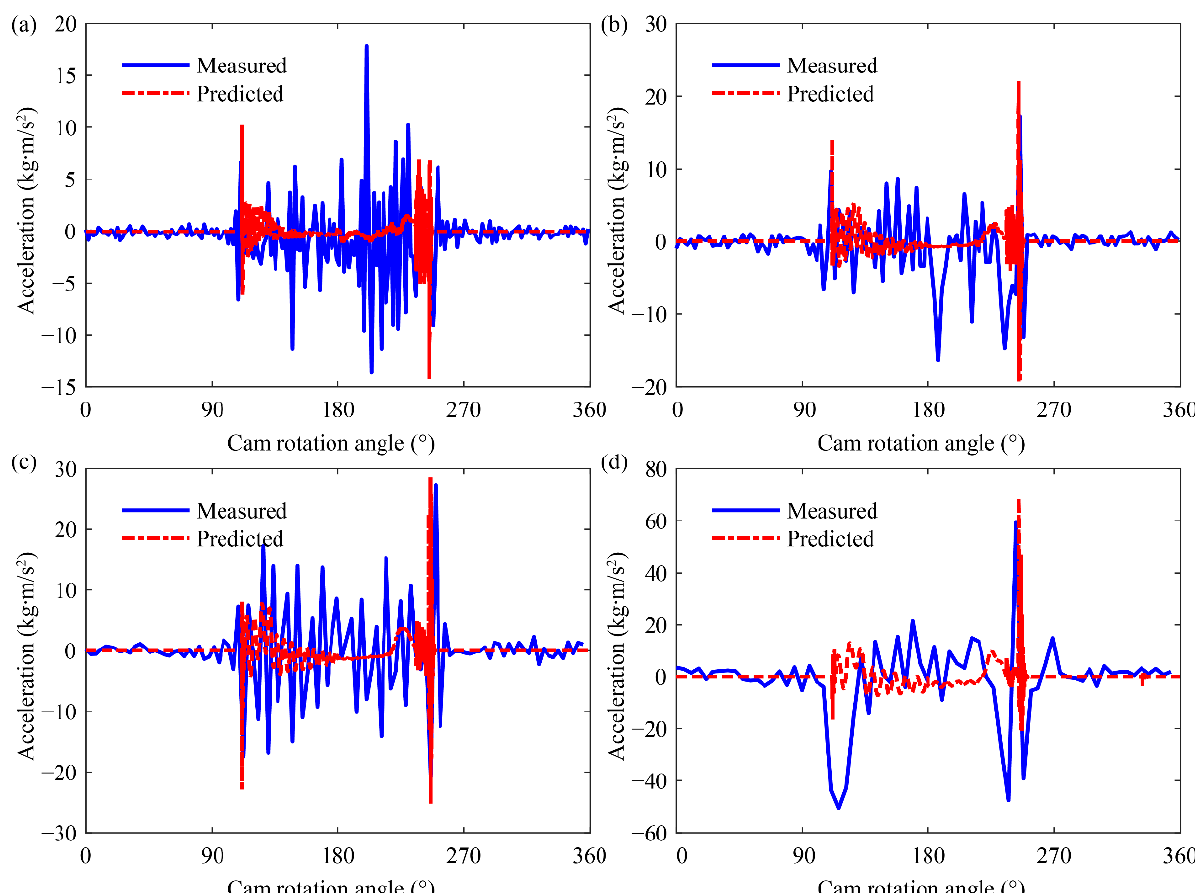
Figure 5. The measured and predicted acceleration at ( a ) 600 rpm, ( b ) 900 rpm, ( c ) 1200 rpm and ( d ) 1800 rpm.